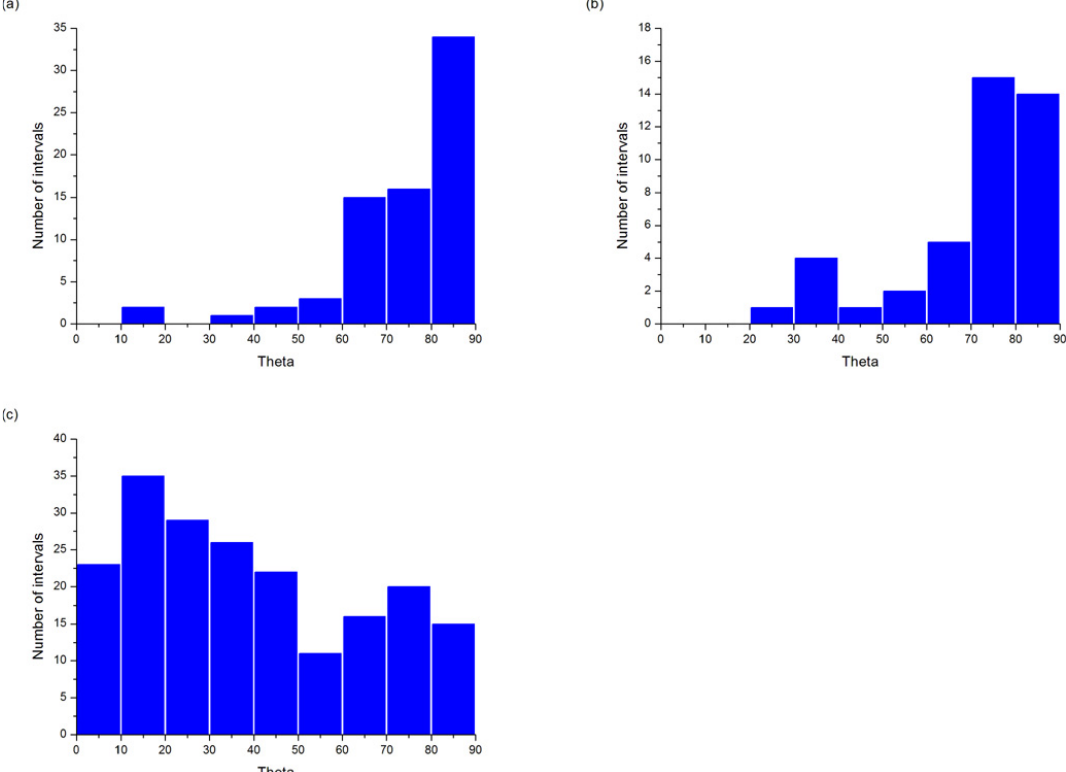
Fig. 3. (a) , (b) The histograms for the magnetic field elevation angle (atan( B z / B x )) of the magnetic holes detected by Cluster and TC-1. The B z and B x are their background magnetic field in the GSM coordinate system. (c) The histogram for magnetic field elevation angle of randomly selected Cluster plasma sheet